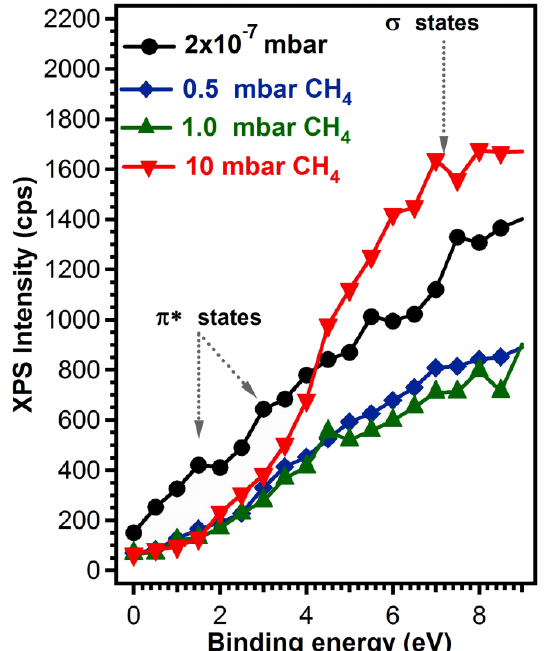
Figure 5. Valence band photoemission for carbon films synthesized in vacuum or in 0.5, 1 and 10 mbar CH 4 on buffered Si (100)